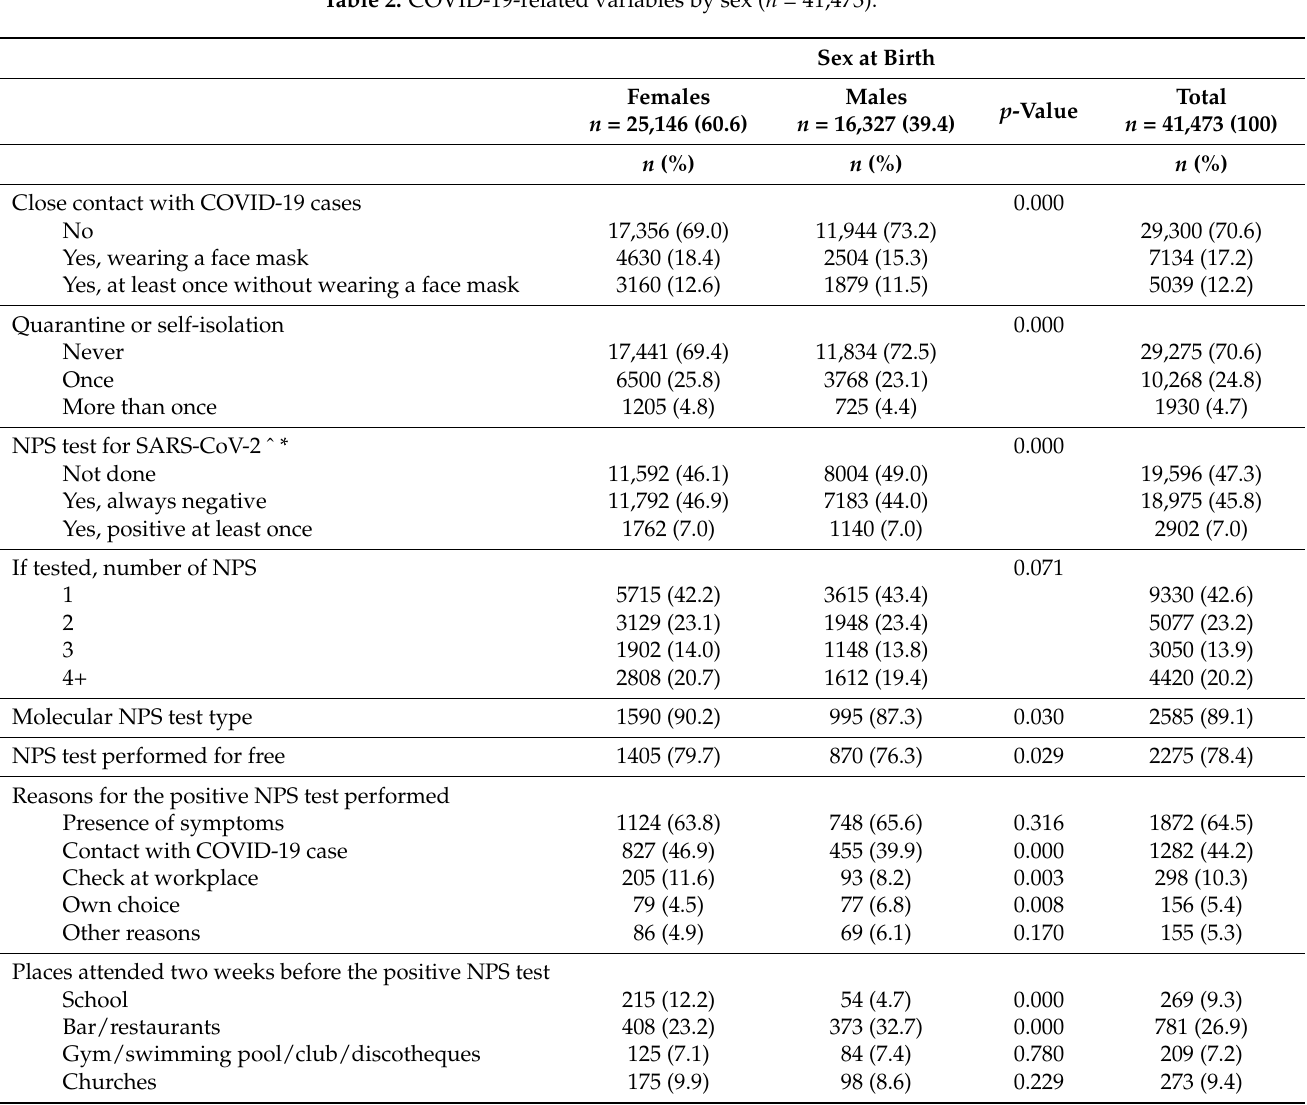
Table 2. COVID-19-related variables by sex ( n =